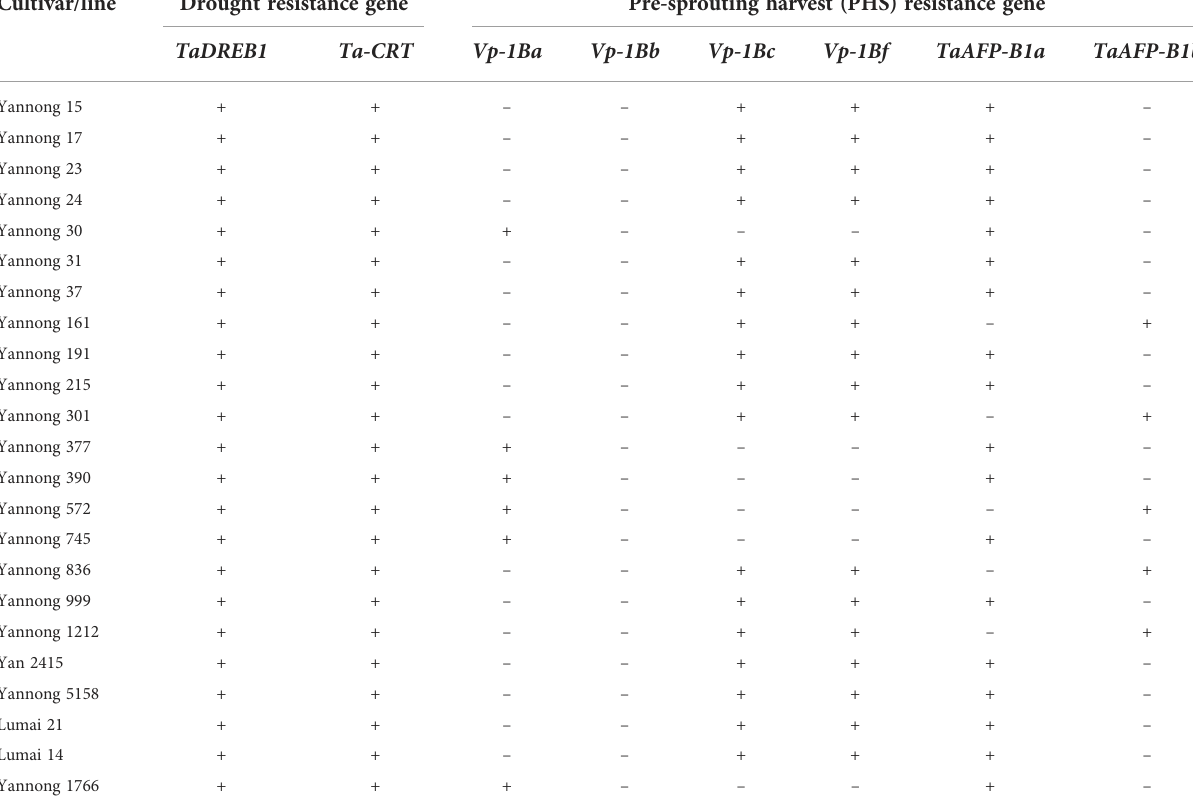
TABLE 5 Detection of drought resistance genes and pre-harvest sprouting (PHS) resistance genes in 23 Yannong cultivars/lines.